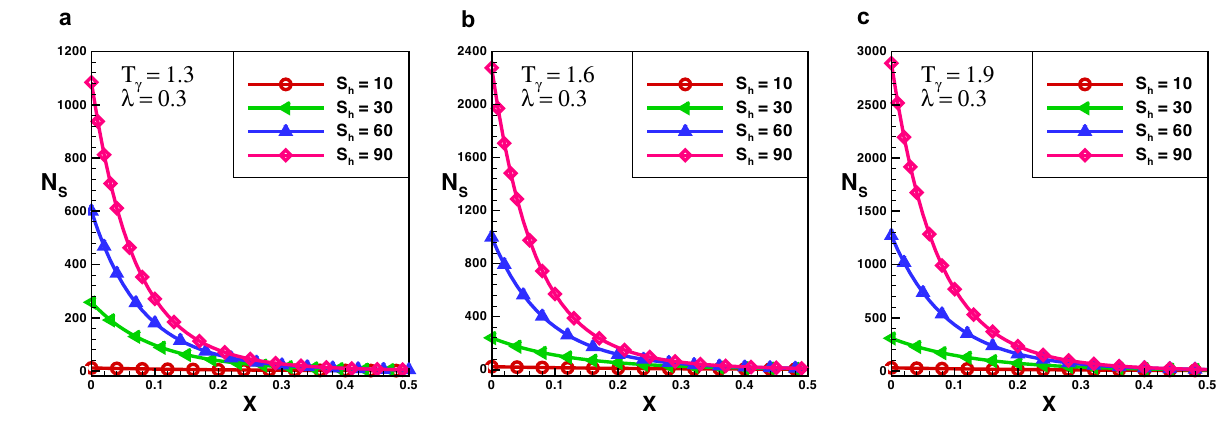
Figure 6. Entropy generation number in decay exponential porous fin for (cid:31) = 0.3 .